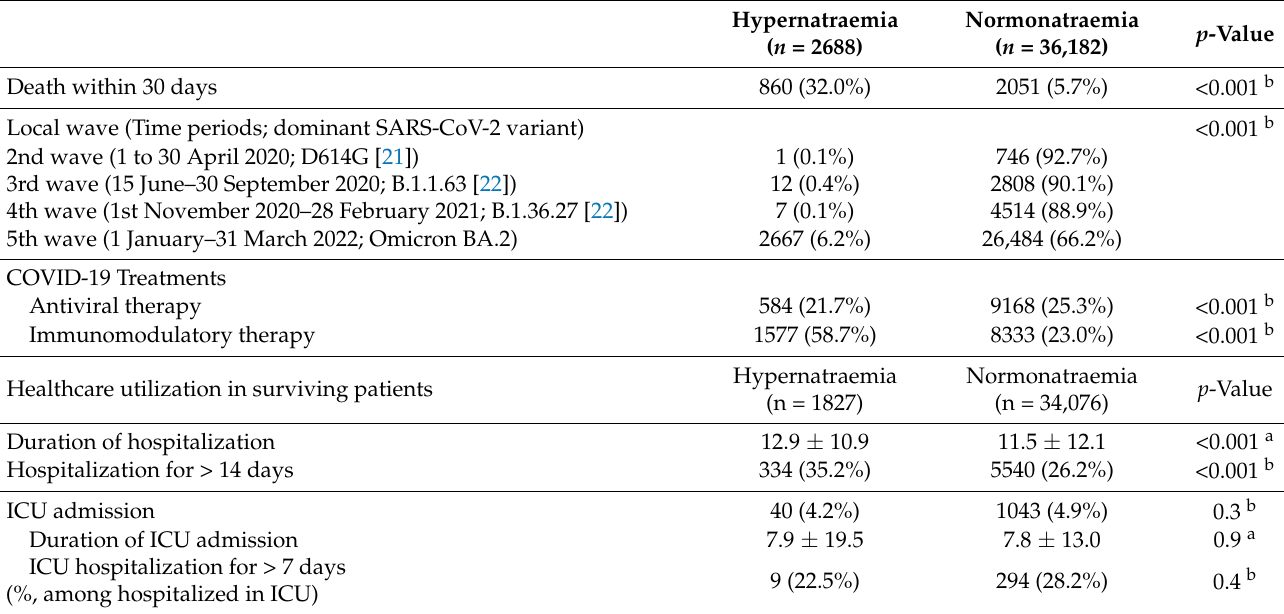
Table 6. Clinical outcomes in COVID-19 patients with hypernatraemia or normonatraemia at presen- tation and relationship with different local waves.